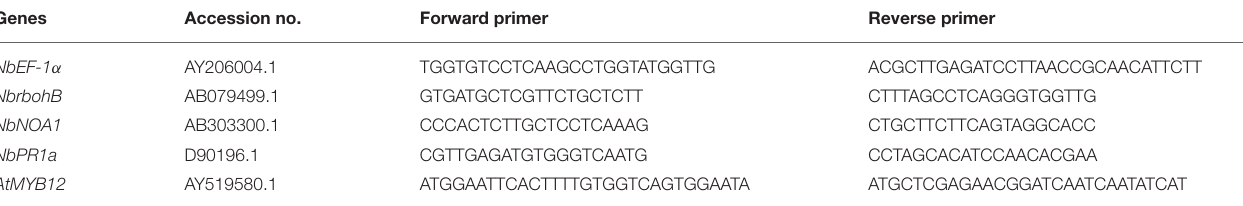
TABLE 1 | Gene-specific primers for quantitative real-time PCR.